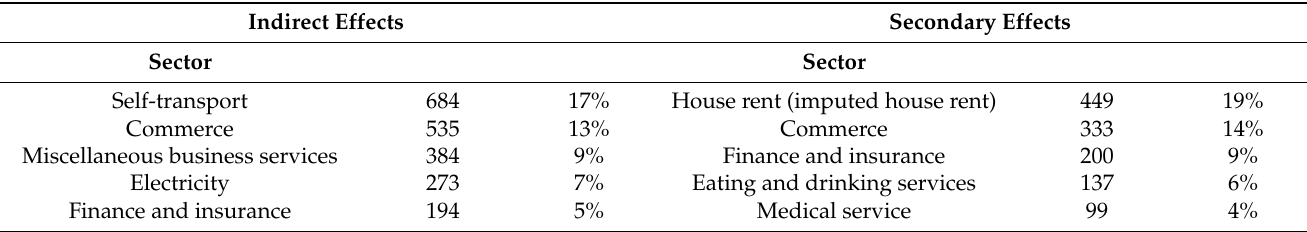
Table 9. Indirect and secondary effects (in thousands of yen) of issuing a premium voucher, with percent contribution to production value induced: top five sectors.